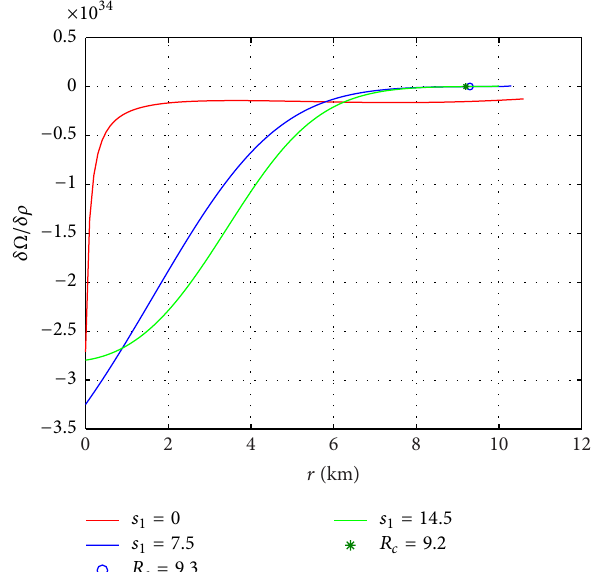
Figure 3: Cracking of PSR J1614-2230 with 𝛾 = 0.140 , 𝛼 = 0.33 , and = 0, 7.5, 14.5 . 𝑠 1